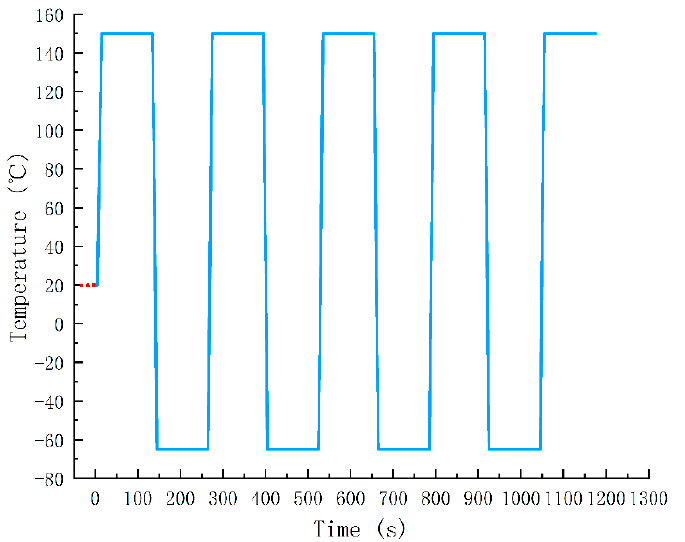
Figure 2. Schematic representation of the thermal cycling.